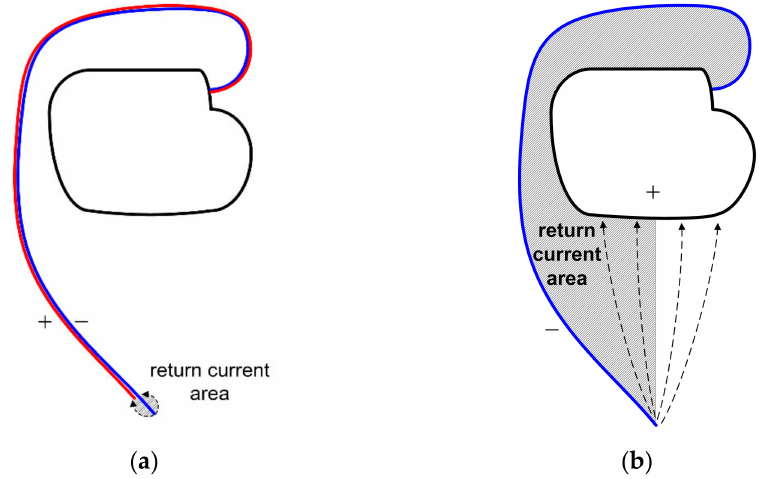
Figure 2. Scheme of a pacemaker and electrodes deployment: ( a ) bipolar, where the flow of stimu- lation return current is limited to the uncovered part of the electrodes; ( b ) unipolar, with a return current flow through the whole cardiac tissue back to the PM body and thus a larger capture area for differential-mode